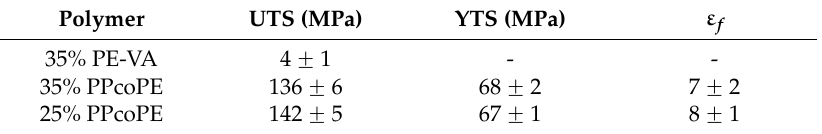
Table 2. Tensile Test